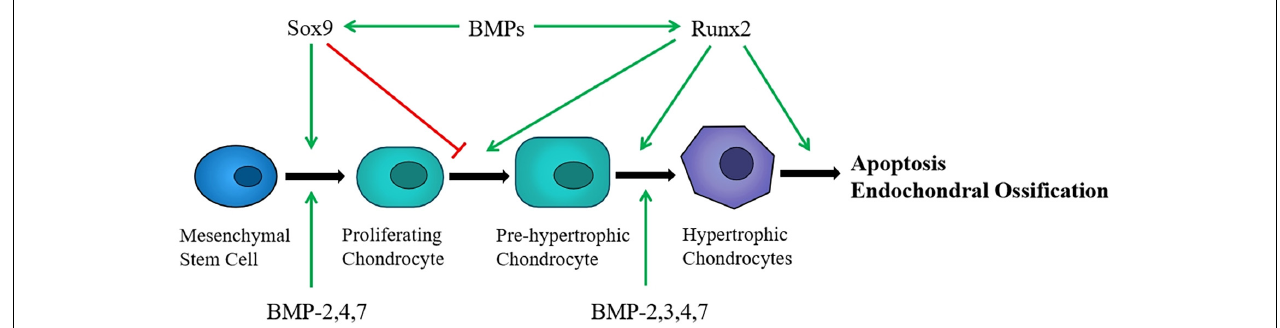
FIGURE 1 | Chondrocytes originate from MSCs and undergo a series of differentiation processes. Sox9 induces MSCs differentiate into chndrocytes and promotes proliferation, whereas Runx2 stimulates chondrocyte hypertrophic. BMPs affect certain stages of chondrocyte differentiation and regulate the expression of Sox9 and